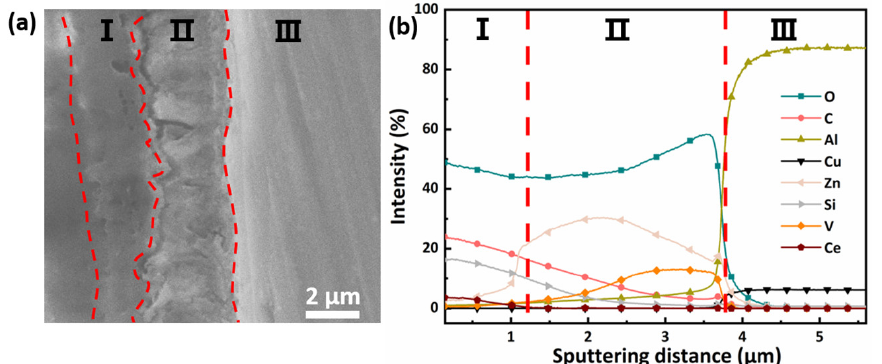
Figure 3. ( a ) Cross ‐ section SEM image and ( b ) GDOES depth profile of LDH ‐ V/SG ‐ Ce (I: SG film; II: LDH film; III: AA2024 matrix).